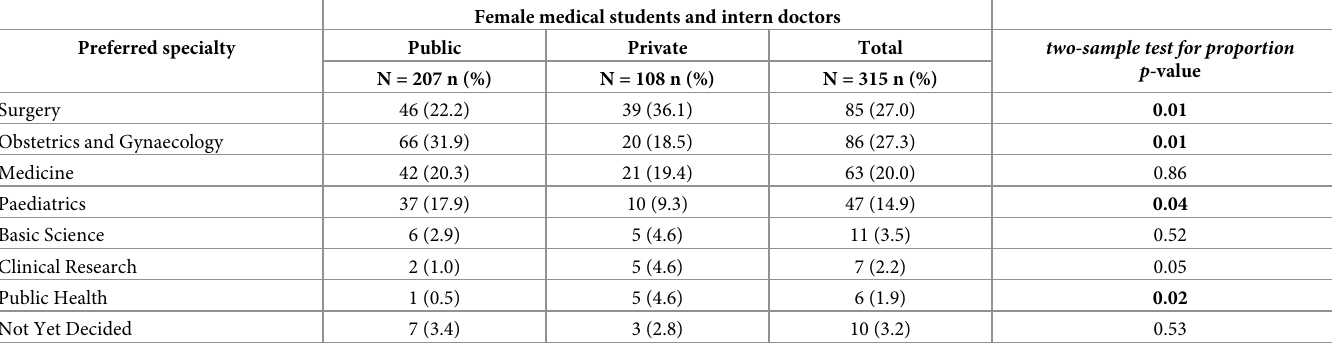
Table 5. Female medical students’ reported preference of specialties (N =